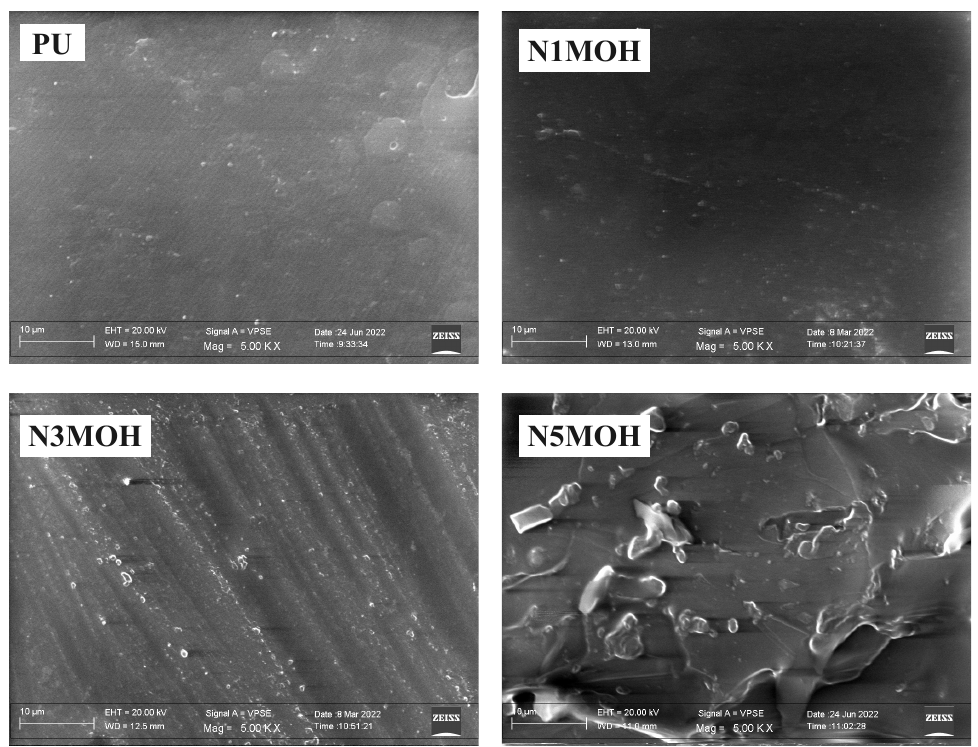
Figure 3. FESEM (5000 × ) of PU composites with different nMOH contents. While the PU sample demonstrated a smooth surface, the nanocomposites presented more roughness in the